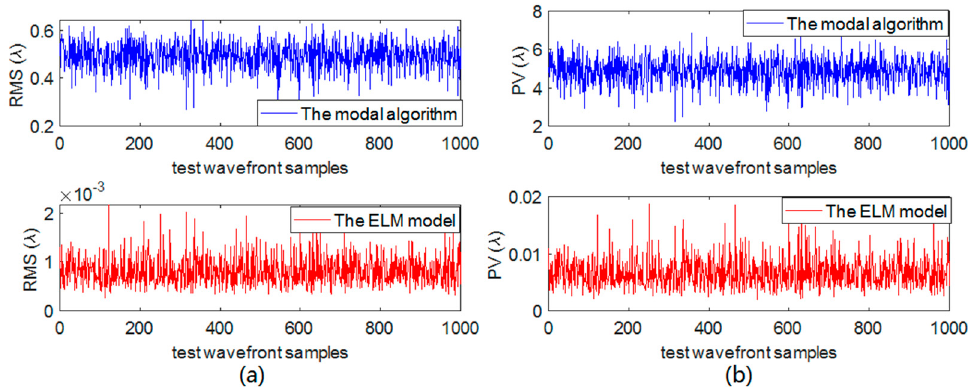
Figure 10. ( a ) The RMS value of the residual wavefront. ( b ) The PV value of the residual wavefront.